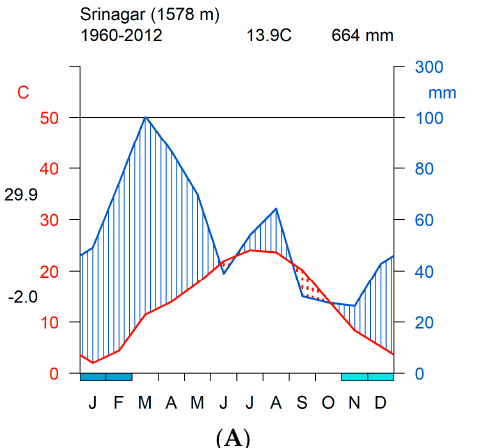
Figure 1. Map of the sampling site and meteorological station in northwestern Himalaya.